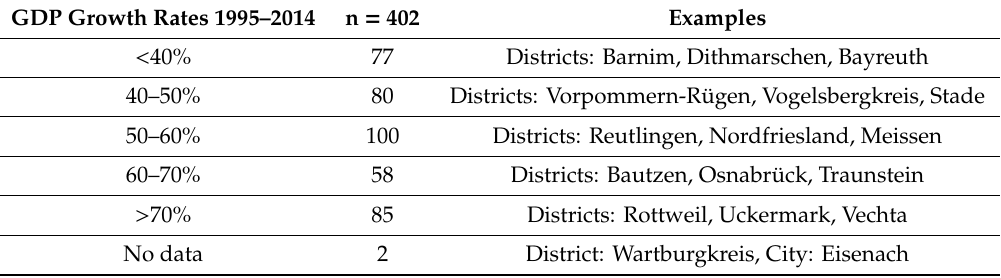
Table 3. Distribution of German districts and towns with district status according to development of